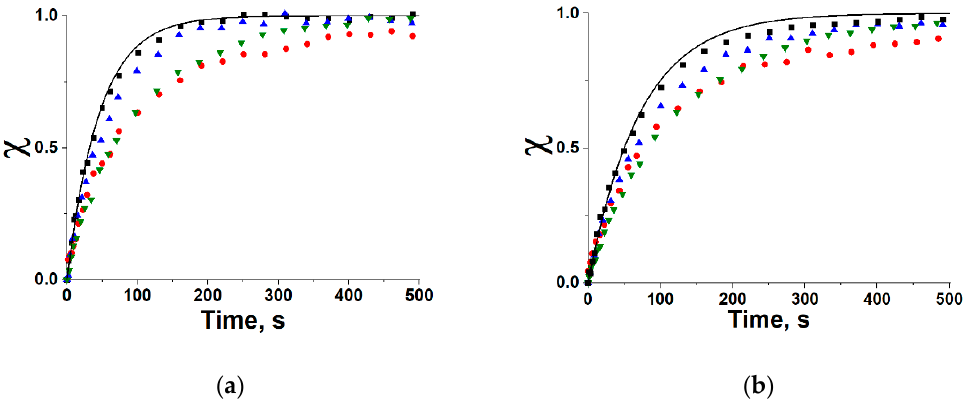
Figure 4. Dimensionless methanol uptake ( a ) and release ( b ) curves for the compacted MaxSorb